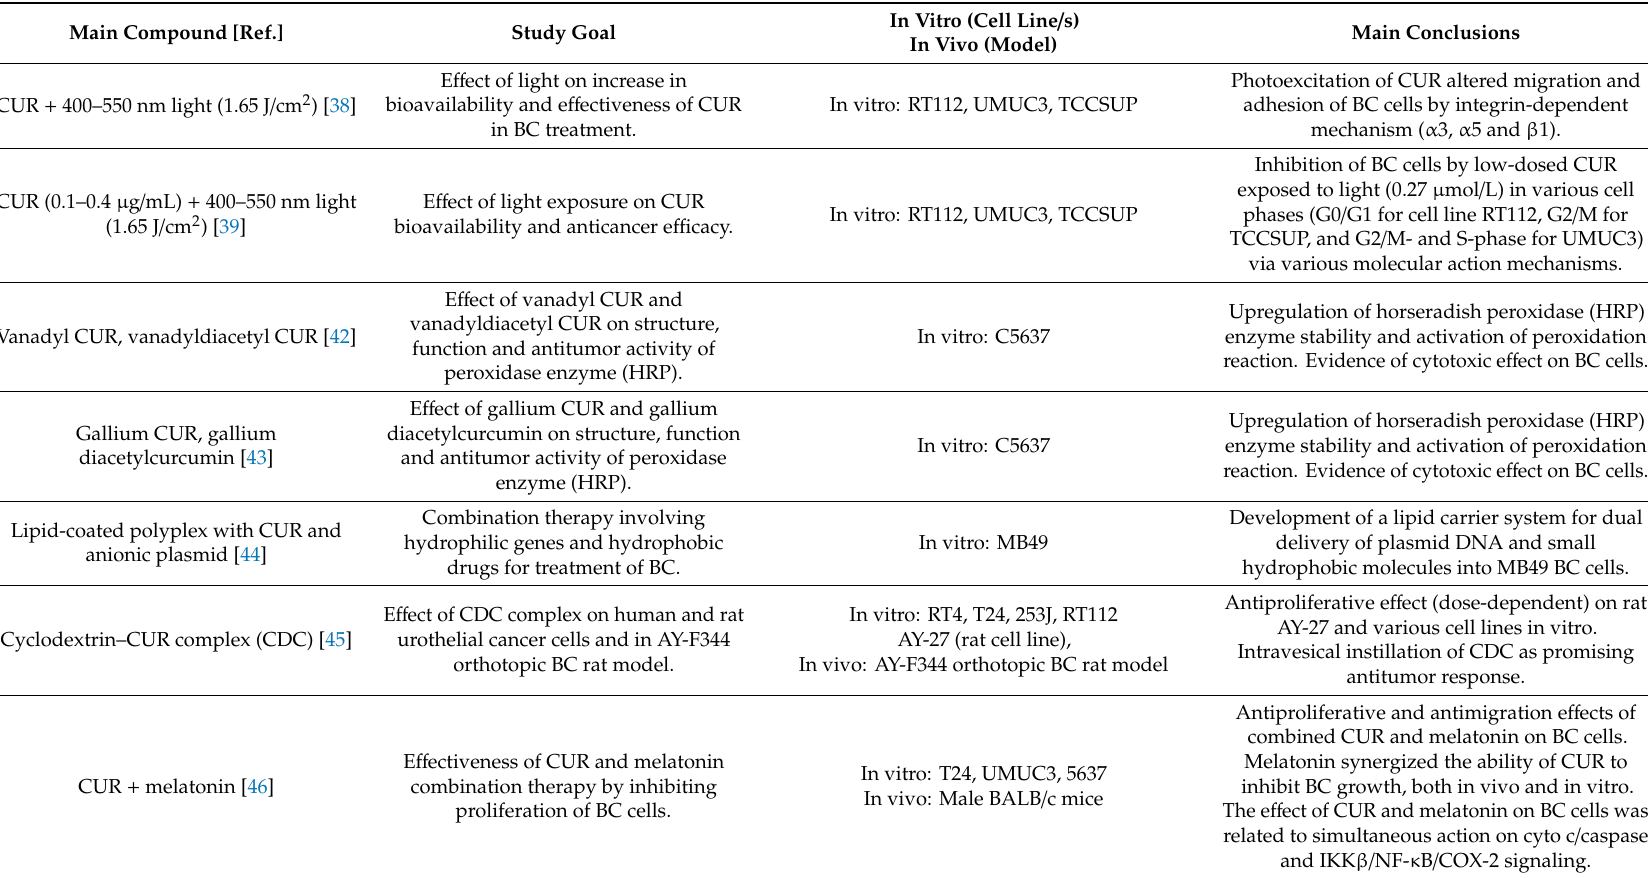
Table 1. Profiles of publications concerning CUR selected for the